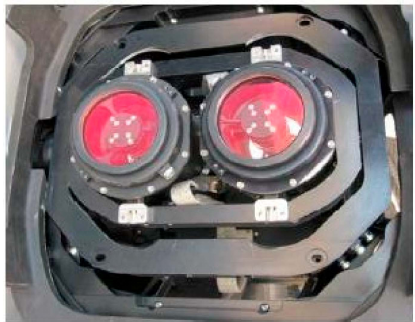
Figure 2. Dual Lenses of VisionMap